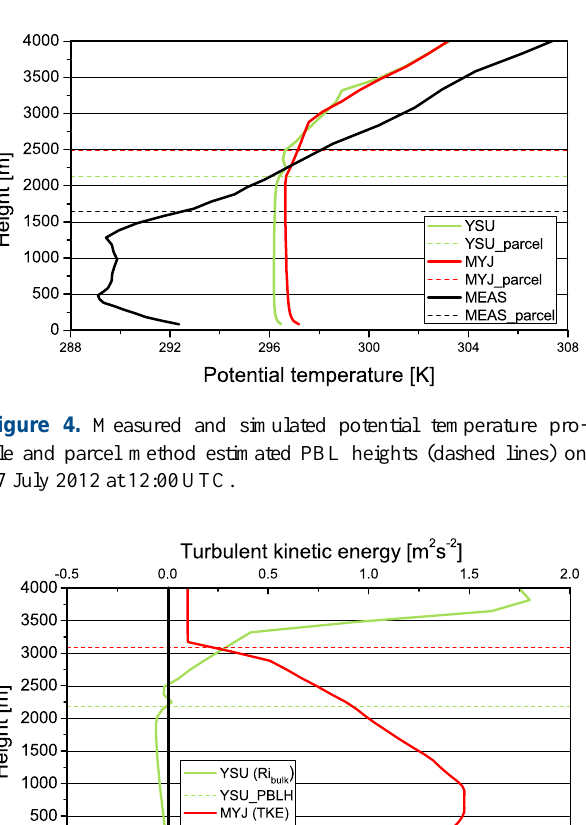
Figure 4. Measured and simulated potential temperature profile and parcel method estimated PBL heights (dashed lines) on 17 July 2012 at 12 UTC.